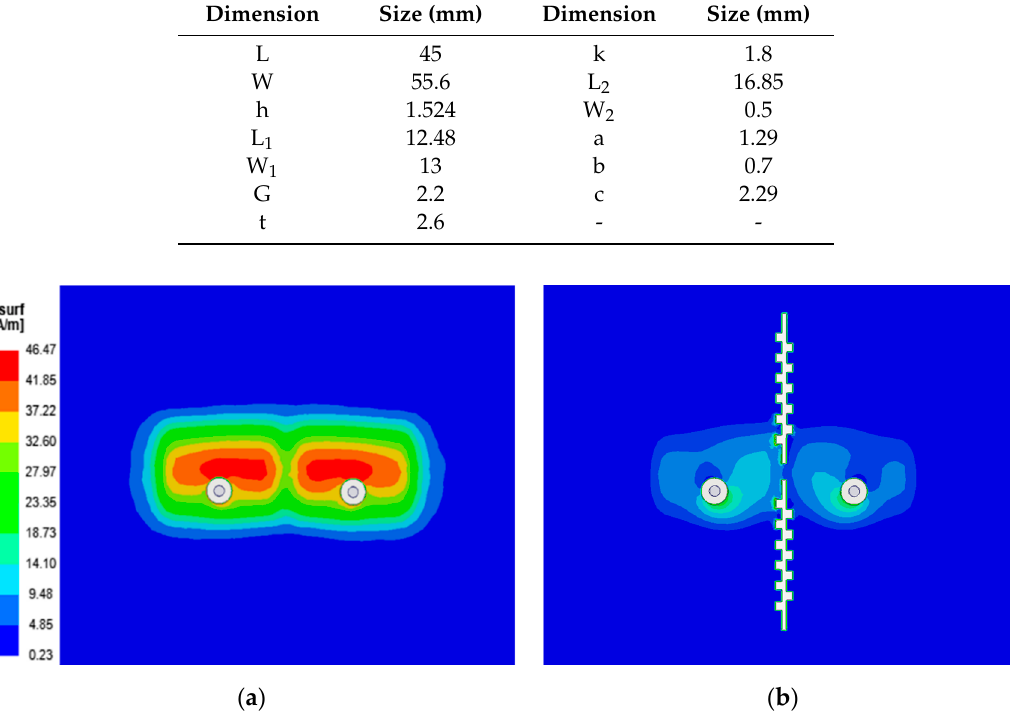
Figure 10. S 11 and S 21 of designed MIMO antenna with and without DGS, focus on 5.8 GHz. Table 1. Preferred dimension sizes of the designed MIMO antenna with DGS.